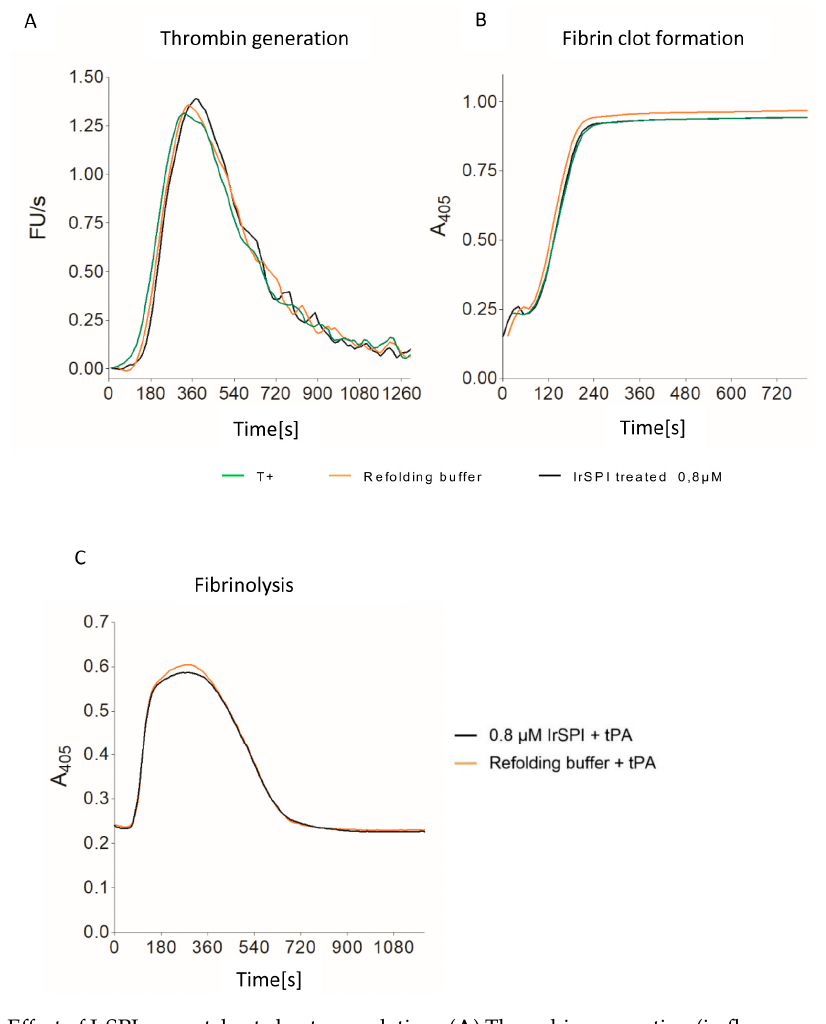
Figure 5. E ff ect of IrSPI on vertebrate host coagulation. ( A ) Thrombin generation (in fluorescence unit / s) triggered by adding 10 mM CaCl2 to platelet-poor plasma containing tissue factor and phospholipid (PPP-reagent). Curves in black were obtained in the presence of 0.8 µ M IrSPI in refolding bu ff er, curves in orange in refolding bu ff er only, and curves in green in 0.15 M NaCl. ( B ) Simultaneous recording of the fibrin clot formation detected through the increase of turbidity at 405 nm; legend as in ( A ). ( C ) Fibrin clot formation was triggered as in ( A , B ) except that 6 nM tPA was added before clot formation. Half-lysis times (defined as the time to halve maximum turbidity) were not significantly di ff erent in the presence (curve in black) or absence (curve in orange) IrSPI. Results presented are mean of two independent experiments.